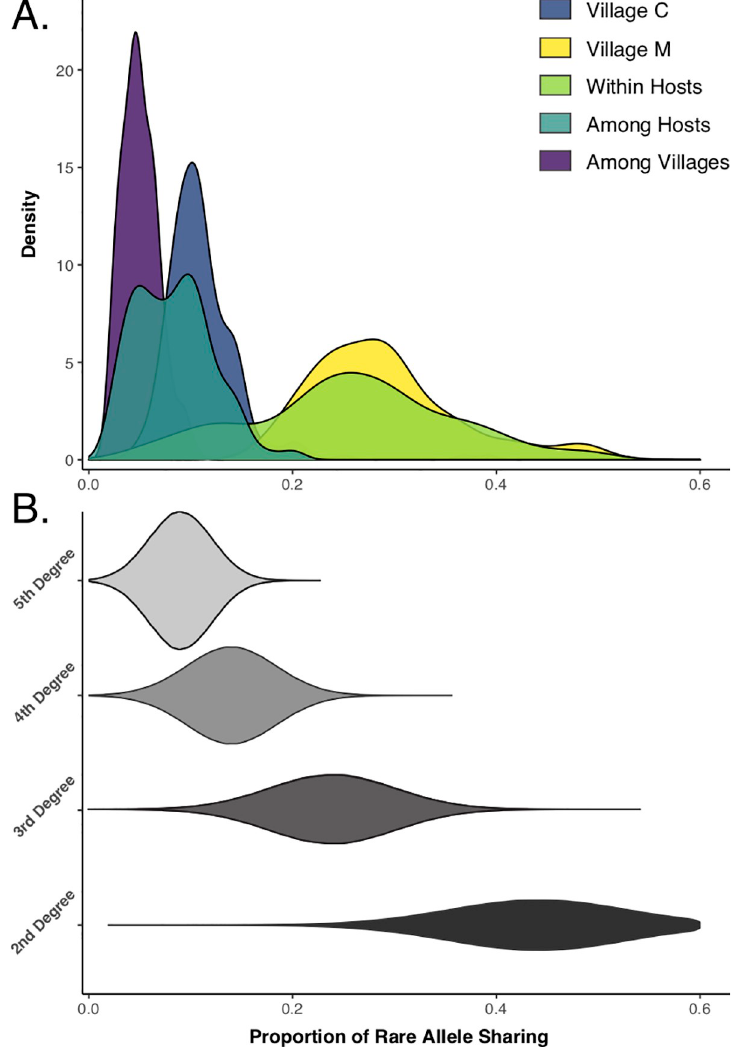
Fig 2. Rare allele sharing between all pairs of miracidia sampled. A) Proportions of rare alleles shared within and among villages and hosts. B) Posterior probabilities for different degrees of relatedness are indicated by height for different proportions of rare allele sharing for 2 nd - 5 th degree relationships (panel adapted from